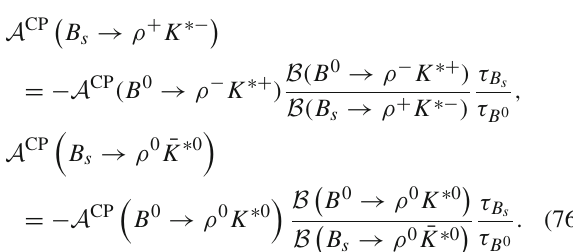
BW denotes the time-like form factor for f 0 ( 500 ) parameterized by Breit–Wigner formulas Bugg denotes the time-like form factor for f 0 ( 500 ) parameterized by D.V. Bugg